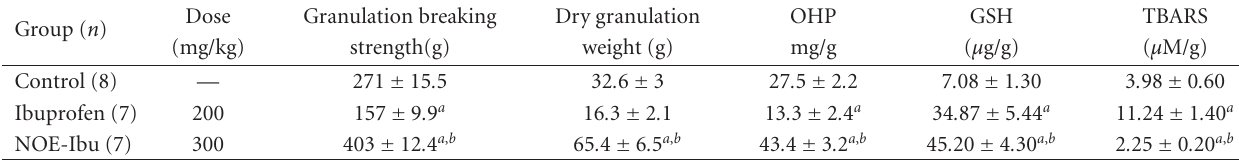
Table 2: E ff ect of ibuprofen and its NOE on the granulation tissues of 10-day-old dead space wounds (by Sche ff es test—SPSS computer The di ff erence between any two means is statistically significant if the mean di ff erence is more than the allowance value calculated. Group ( n